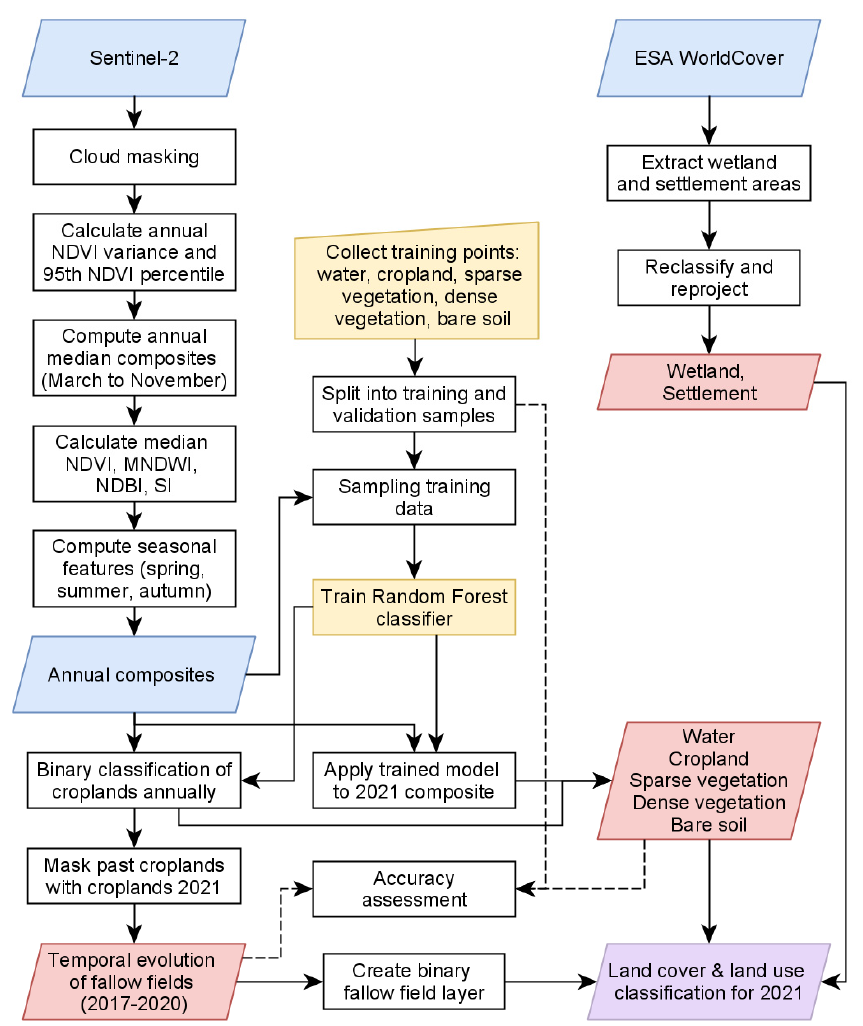
Figure 2. Workflow for regional land cover classification with regards to land cover classes of interest and specification of detected abandoned land.